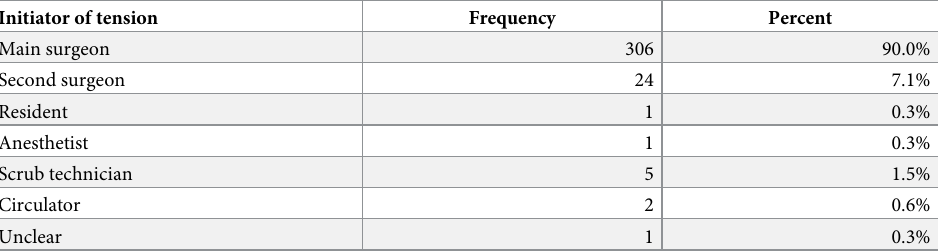
Table 2. Initiators of tensions.